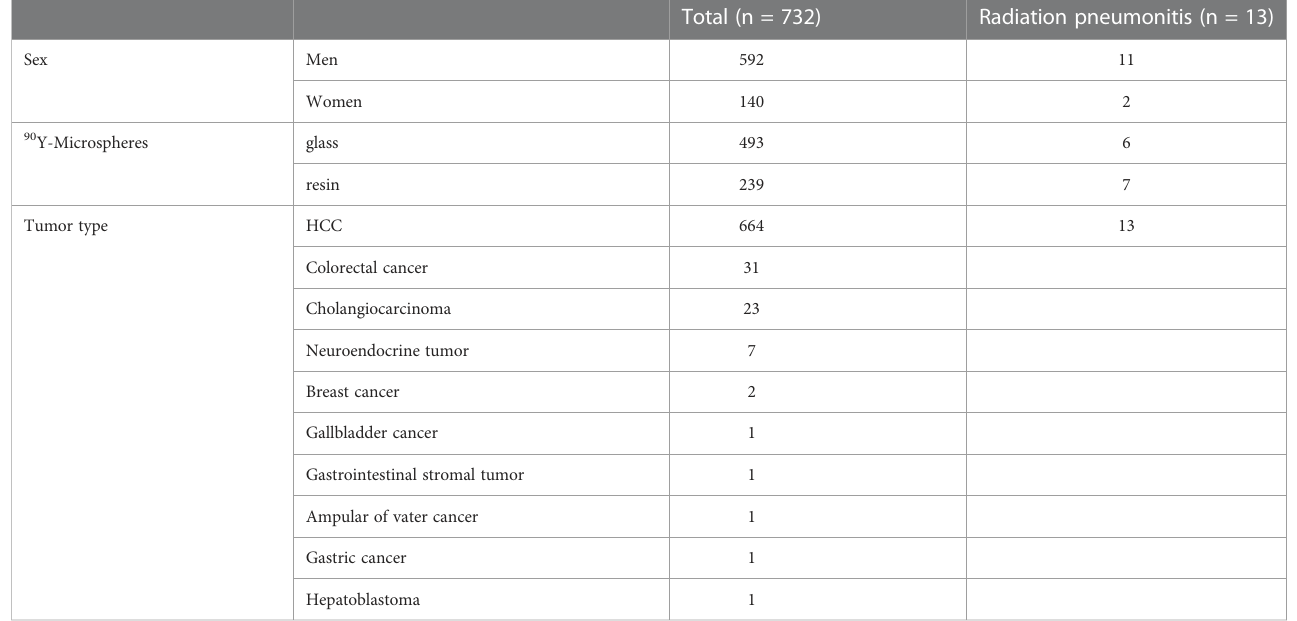
TABLE 1 Baseline characteristics in 732 patients who received